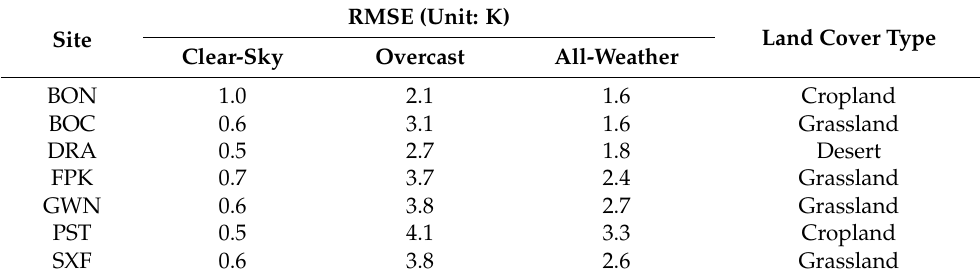
Land Cover Type